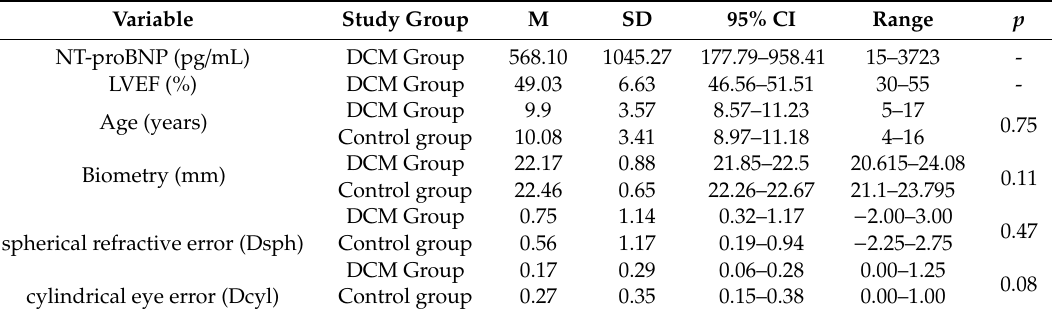
Table 1. Study cohort characteristics.